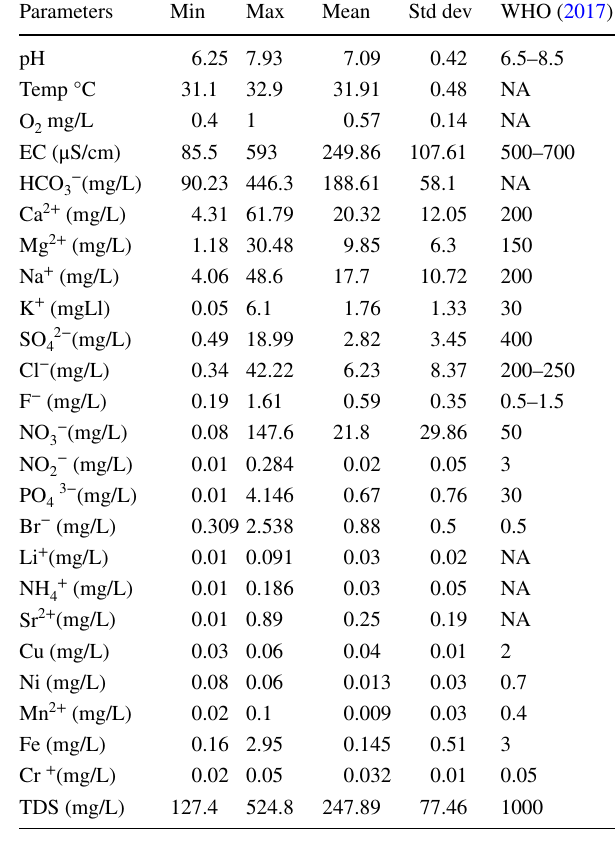
Table 1 Summary of the physiochemical parameters in the study area Parameters